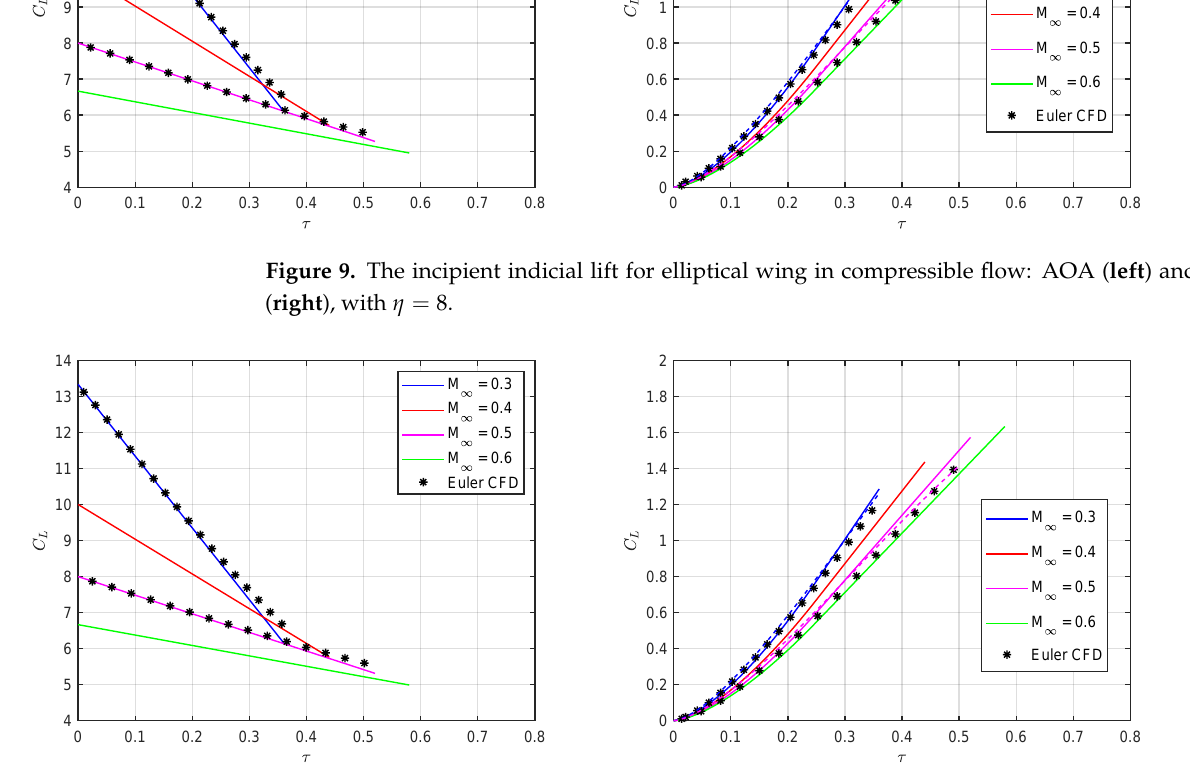
Figure 10. The incipient indicial lift for elliptical wing in compressible flow: AOA ( left ) and SEG ( right ), with η =